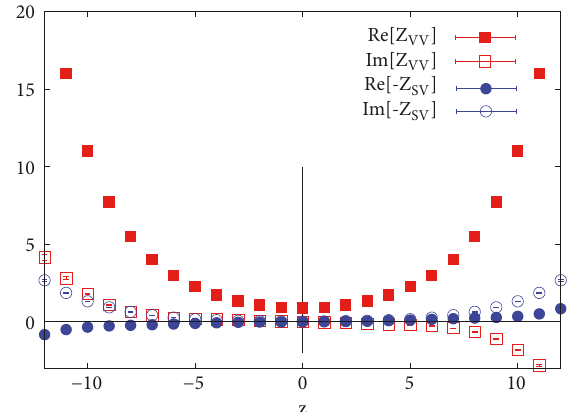
Figure 16: The renormalization function and mixing between vector and scalar nonlocal operators with a straight Wilson